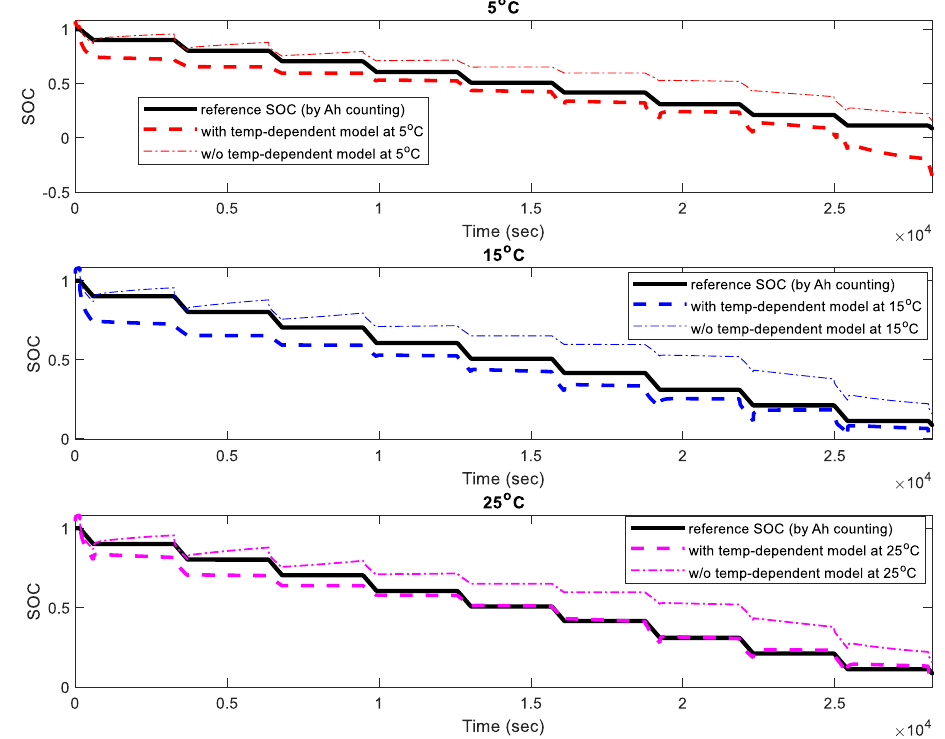
Figure 22. SOC as compared to experimental result at different ambient temperature (5 °C, 15 °C and 25 °C).